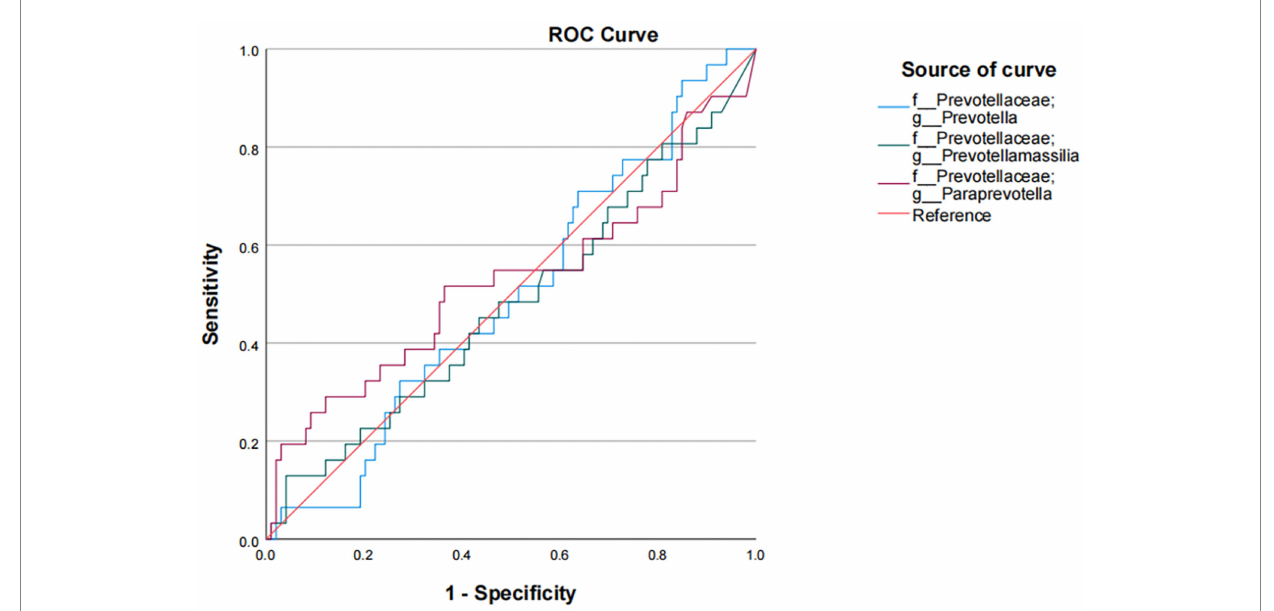
FIGURE 4 Logistic regression analysis of the association of f_Prevotellaceae and g_Prevotella with colorectal